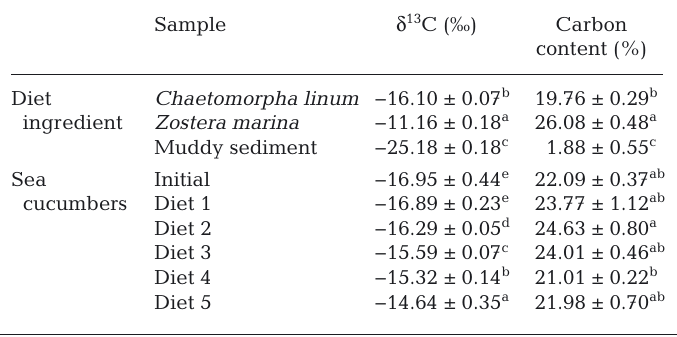
Table 4. Carbon stable isotope ratios ( δ 13 C: ‰) and carbon content (%) of the experimental sea cucumbers and diet ingredients (mean ± SD, n = 4). Values with different letters in the same column are significantly different from each other (ANOVA and Tukey’s multi-comparison; p < 0.05)